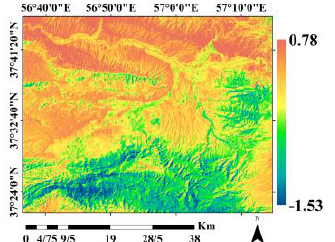
Figure 5. Modeled LST variations based on BCI, Solar incidence angle, and DEM variations using multivariate PLSR.